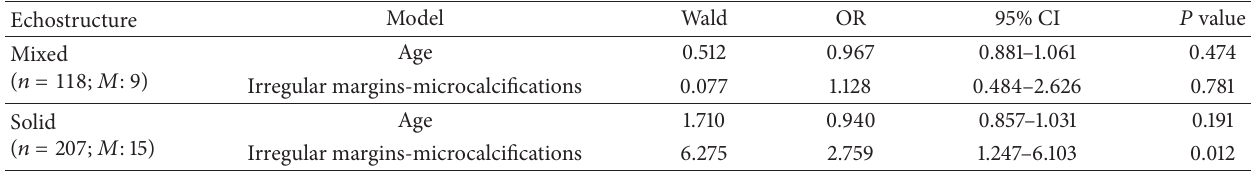
Table 4: Association of the combination between the presence of microcalcifications and/or irregular margins and the presence of malignant